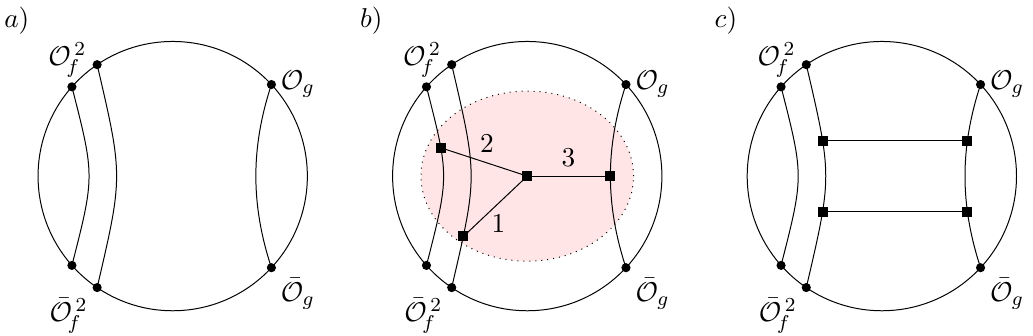
Figure 1 . Three Witten diagrams contributing to (2.1) for the case of n = 2 . Diagram a ) is disconnected and thus contributes at leading order in large N , while the remaining two involve four bulk vertices (denoted by a black square) and so are both suppressed by a factor of 1 /N 2 with respect to the first. Diagram b ) depicts a connected tree-level diagram, while c ) contains a disconnected 1-loop structure. The results derived in this paper focus on the former class of contributions, where in the shaded region one considers all possible ways of obtaining a connected tree-level structure. Such diagrams contain up to three bulk-to-bulk propagators (labelled explicitly by 1 , 2 , 3 in b ) ) and, as mentioned in the text, this makes a direct evaluation of such contributions